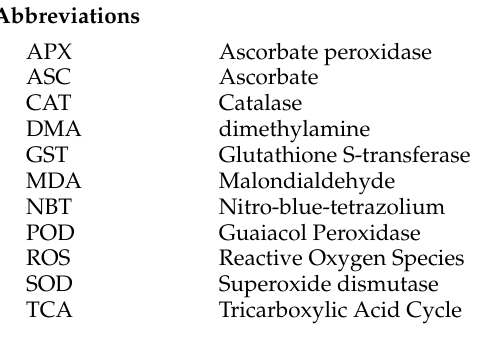
Figure S1: Developmental stages of M. annua . Figure S2: Short term effect of salinity on physiological parameters. Figure S3: Long term effect of salinity on physiological parameters. Figure S4: ‘Mature stage’ M. annua plants under salinity treatment. Figure S5: Ratio of APX, CAT and POD activities to SOD activity in leaves of M. annua during development. Figure S6: Effect of salinity on metabolites’ concentration in M. annua leaf and root. Table S1: GST activity in female and male M. annua leaves under salinity. Table S2: Analysis of variance of metabolites concentration in female and male leaf and root of M. annua under